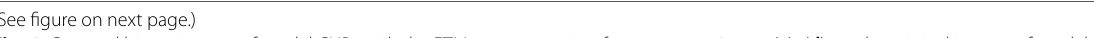
5, 3, 1, 1, 3, and 5 stop). Canopy and grey pixels which − − − + + +